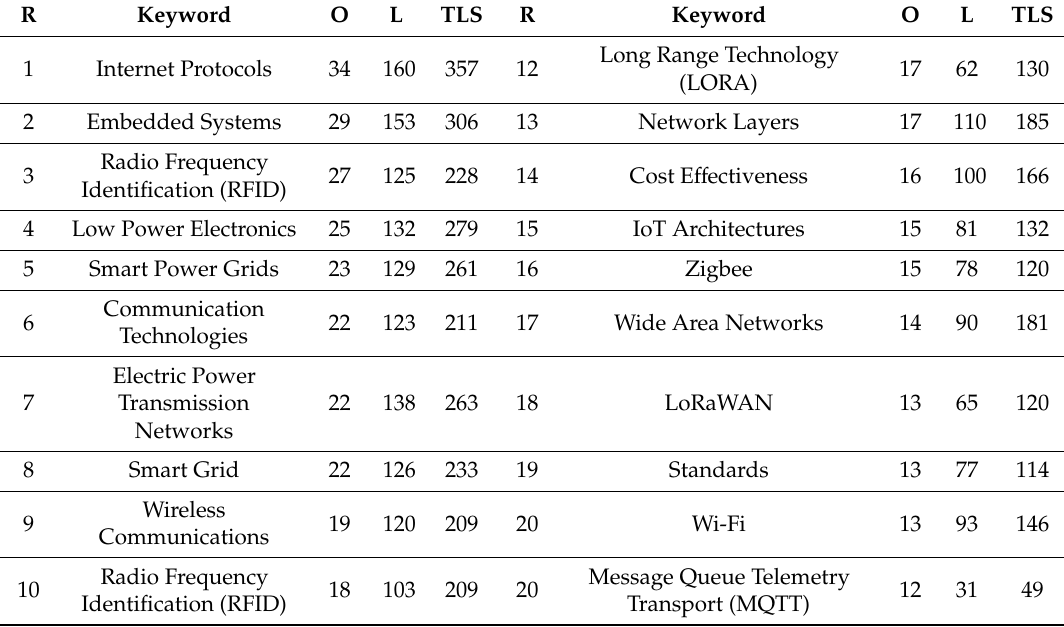
Table 7. Cluster 4. Top 20 keywords (2011–2019).